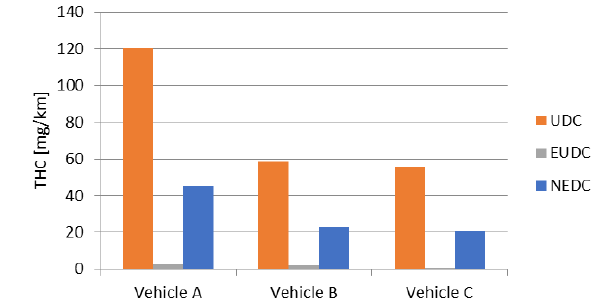
Fig. 4. Hydrocarbons emissions in NEDC test and its particular stages